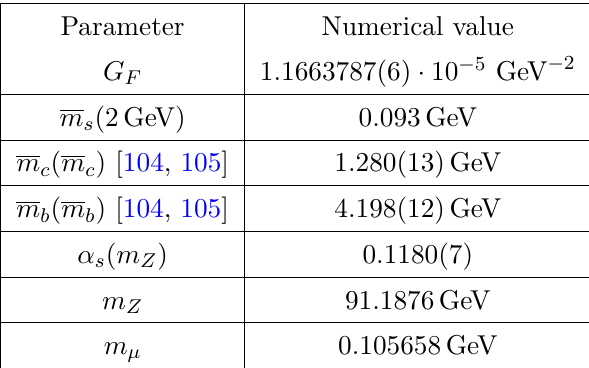
( m ) is the average c c